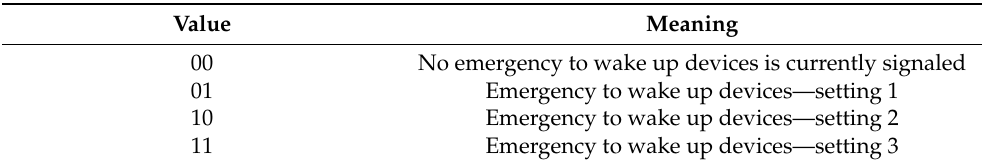
Table 2. The meaning of the AEA wake-up field.